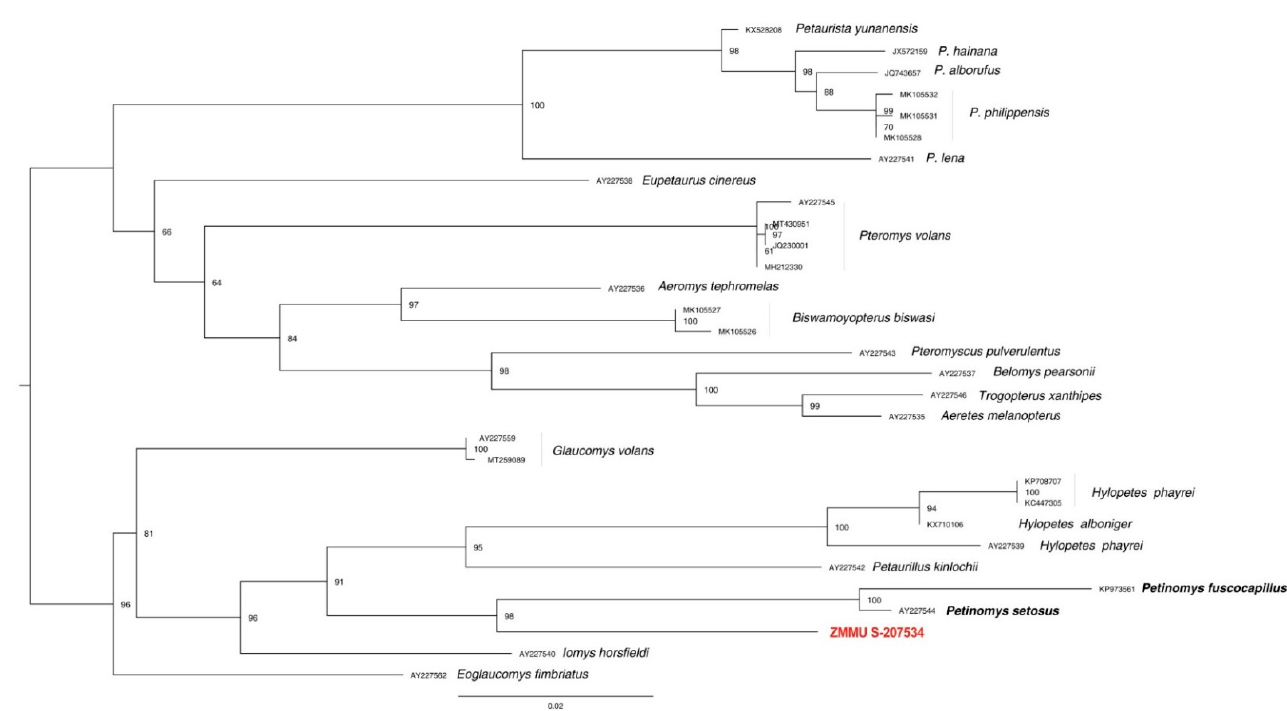
Figure 6. Phylogenetic ML tree for the Pteromyini tribe reconstructed from alignment of the 12S/16S mitochondrial genes. Numbers on tree nodes indicate bootstrap values.